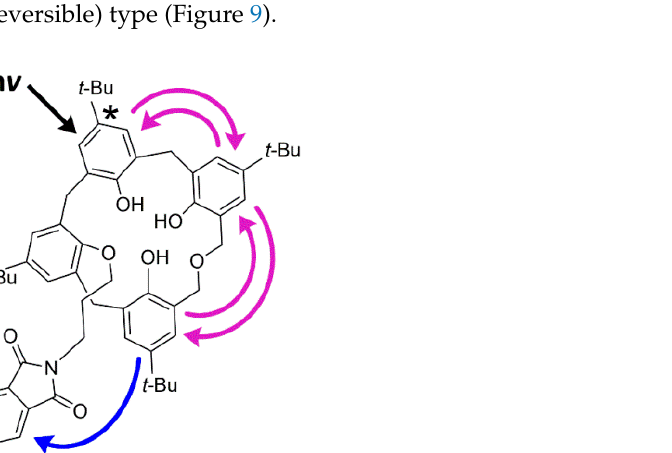
Figure 9. Schematic representation for compound 2a of homotransfer (reversible FRET) within the calixarene followed by heterotransfer (irreversible FRET) from the calixarene to the phthalimide group (only one of many possible excitation outcomes is shown).